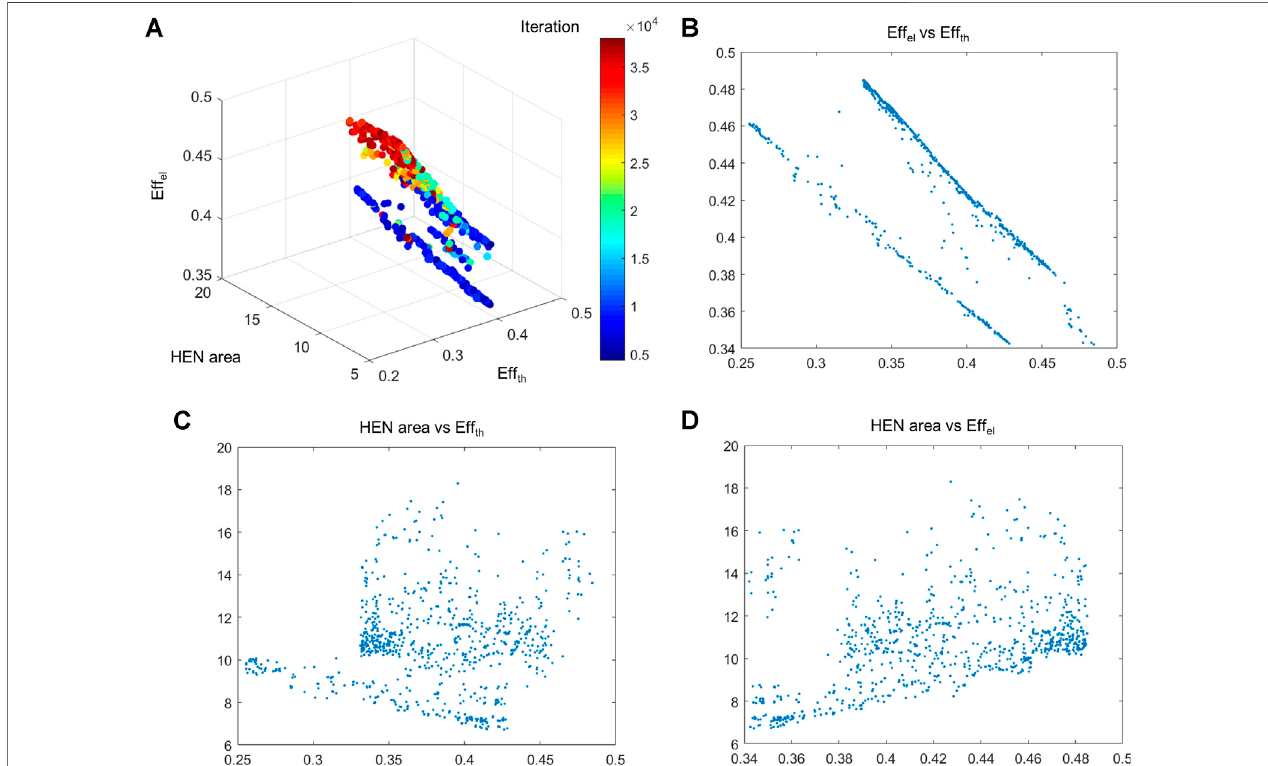
FIGURE 4 | Pareto front of the Bio-SOFC plant (Case 5) optimization. Trade-off among Effel, Effth, and HEX area.